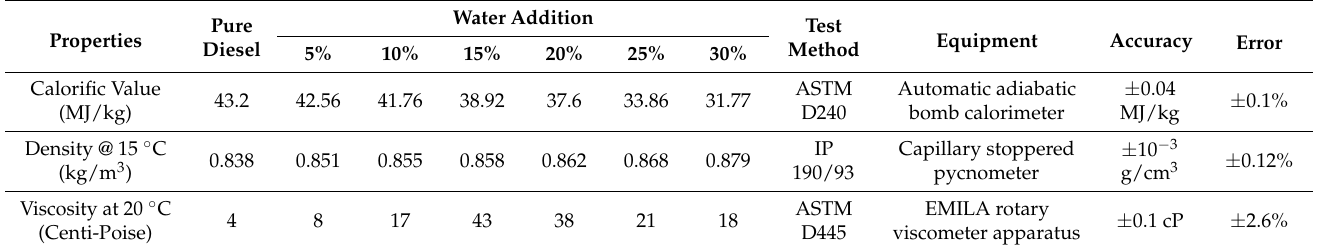
Table 2. Properties of different blends of W/D emulsion